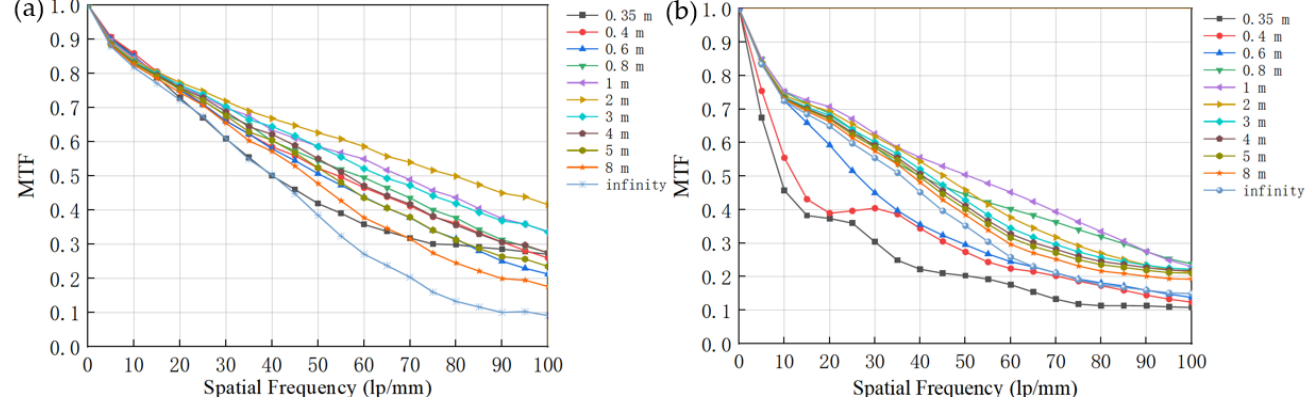
Figure 2. MTFs of the pseudophakic eye model for 0° field of view at 11 object locations. ( a ) Under 3 mm pupil diameter. ( b ) Under 4.5 mm pupil diameter.